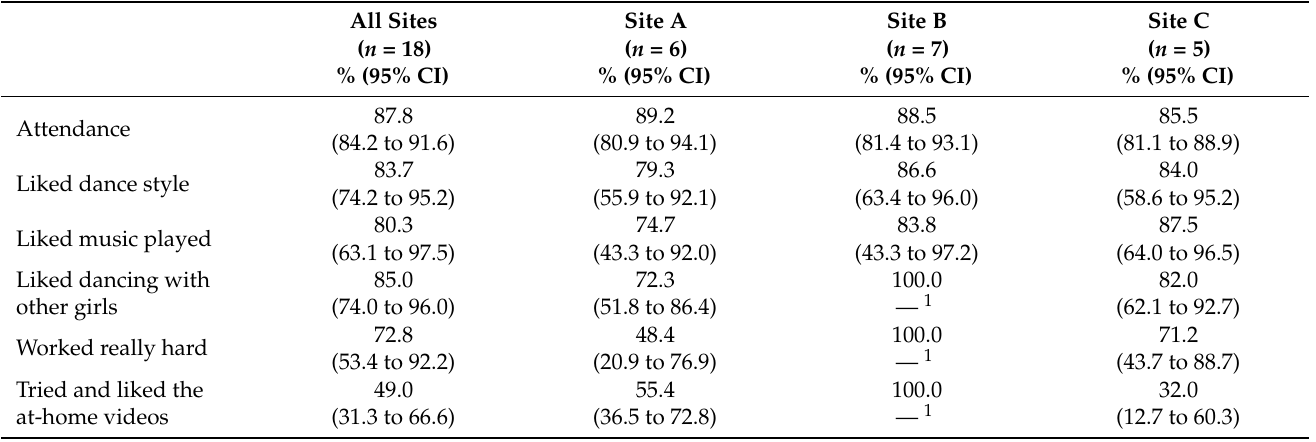
Table 3. Assessment of participants’ enjoyment of the dance program over the 12-week dance